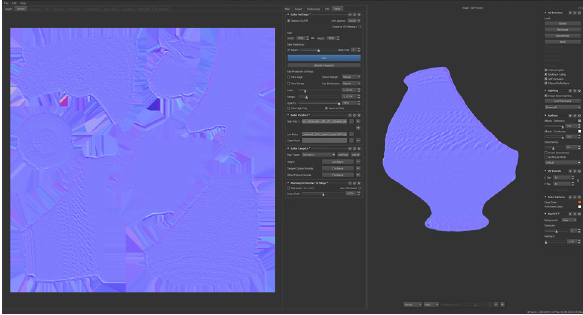
Figure 6. Tangent space normal map baking in Knald.